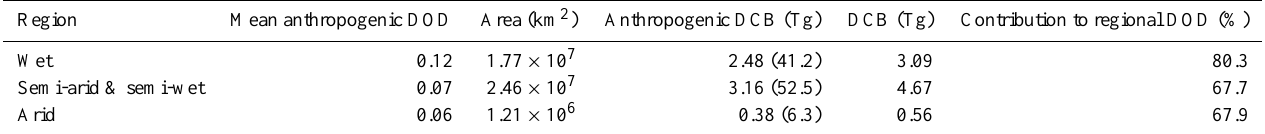
Table 1. Summary of anthropogenic dust annual mean statistics by climate region – anthropogenic dust optical depth (ADOD); total regional area; regional anthropogenic dust column burden (DCB) (and percent contribution by region); regional dust column burden (DCB); and percent contribution to regional DOD.